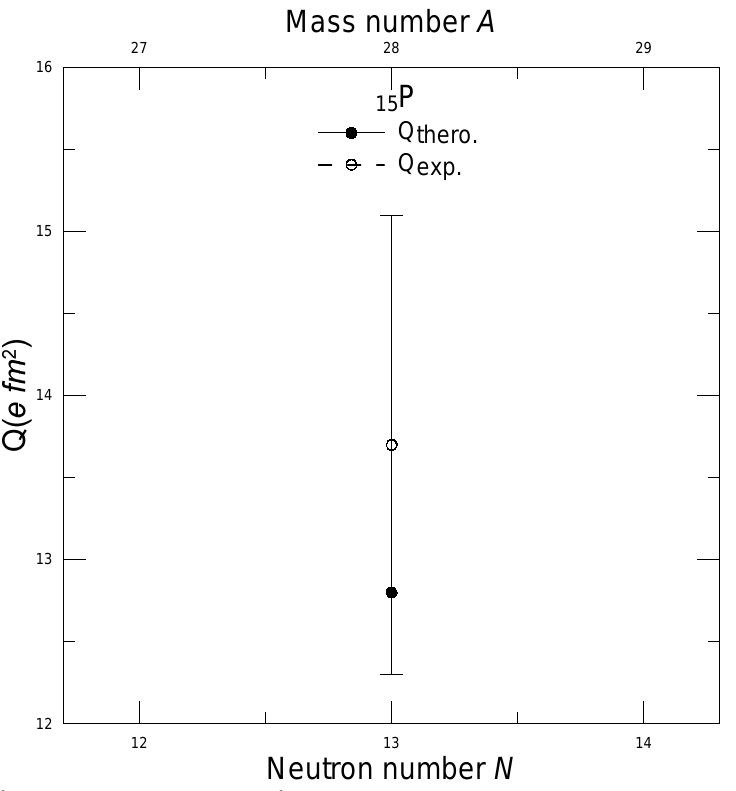
Fig. 3: Experimental [18] and theoretical quadrupole moments versus neutron number for P